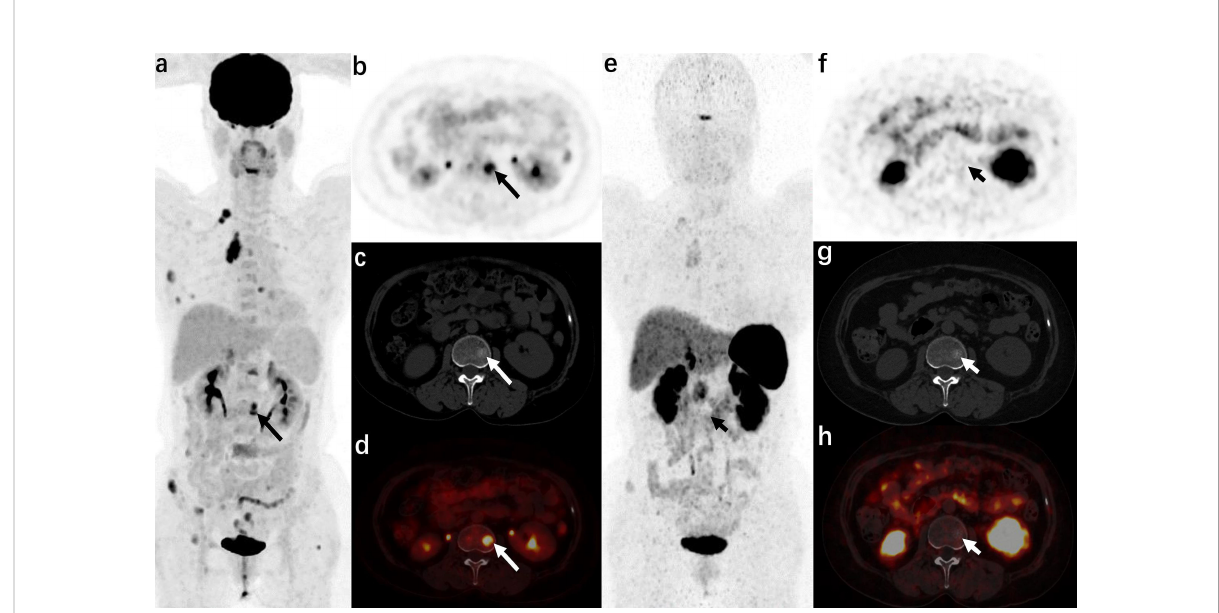
TABLE 4 Detection rate of 18 F-FDG PET/CT and 68 Ga-DOTANOC PET/CT at different metastatic locations of the staging group. 18 F-FDG PET/CT